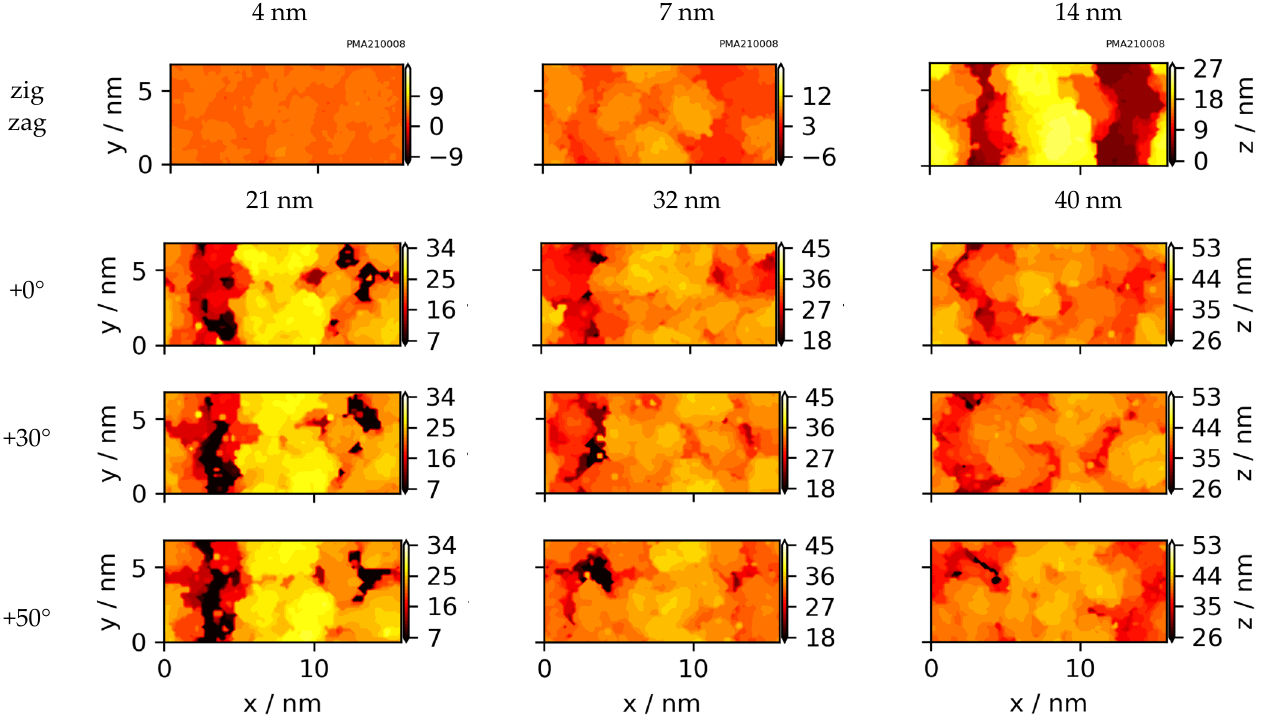
Figure 10. Surface morphology of the zig-zag structure from serial bi-deposition (first row) for 4, 7 and 14 nm mean height, and continued growth with glancing angle deposition under 0°, 30° and 50° with rotating substrate for 21, 32 and 40 nm mean height. Table 2. Evaluation of the first layer region between 7 and 20 nm after deposited second layer and the second layer region between 25 and 47 nm with different angles of incidence performed three times each. Given are the values of the fill factor and the birefringence for each single structure and the mean and standard deviation calculated from each three